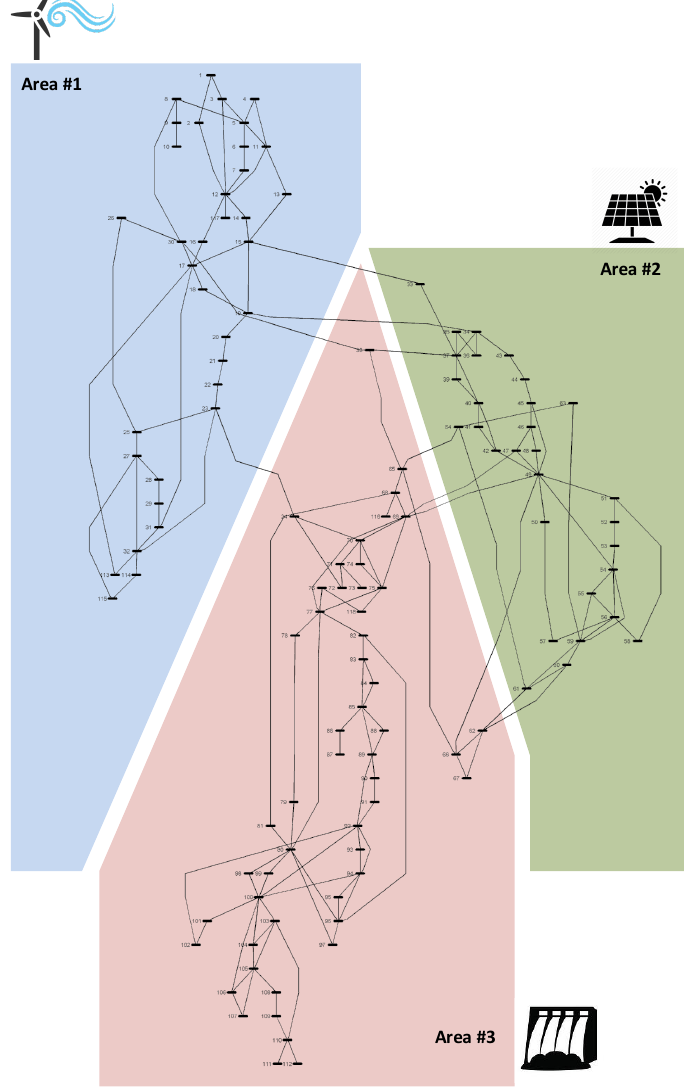
Figure 4. 118 bus system divided in three